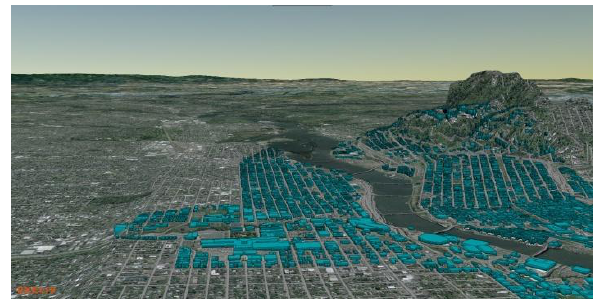
Figure 3 - Buildings draped on DEM